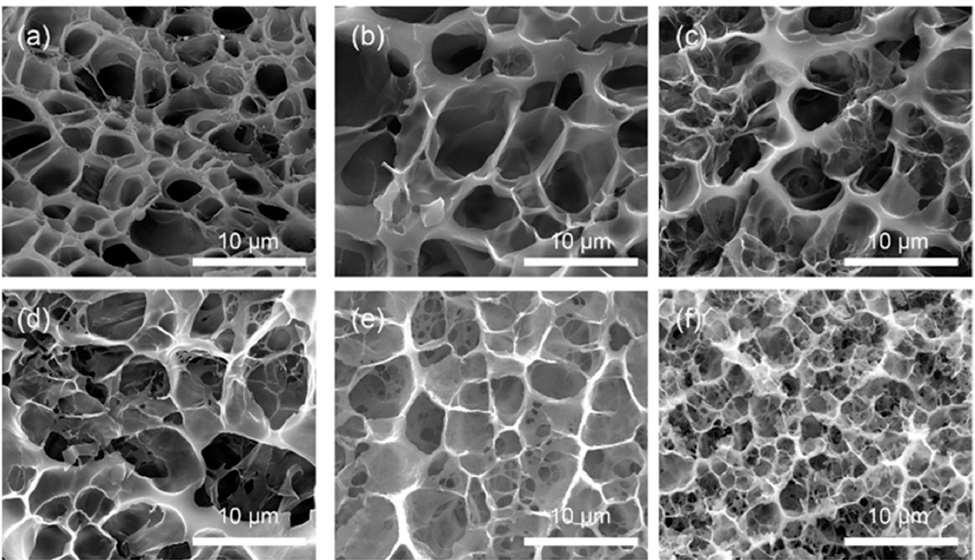
Figure 1. The typical scanning electron microscopy (SEM) images of NC-G and OR-G gels. ( a ) NC-G0, ( b ) NC-G20, ( c ) NC-G40, ( d ) NC-G60, ( e ) NC-G80, and ( f ) OR-G60.